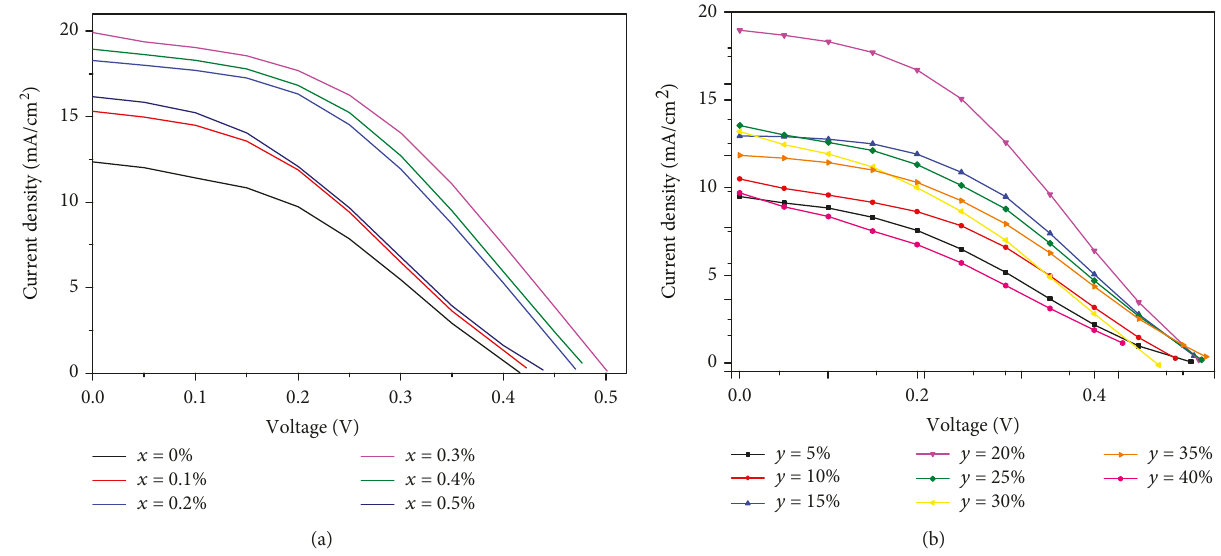
Figure 3: Photocurrent density-voltage ( J - V ) curves of (a) CdSe:Cu 2+ -QDSSCs and (b) CdSe:Mn 2+ -QDSSCs.